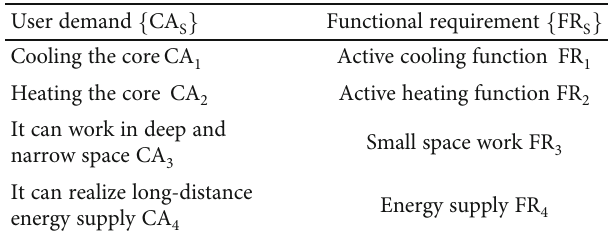
Table 1: Comparison of user requirements and functional requirements.